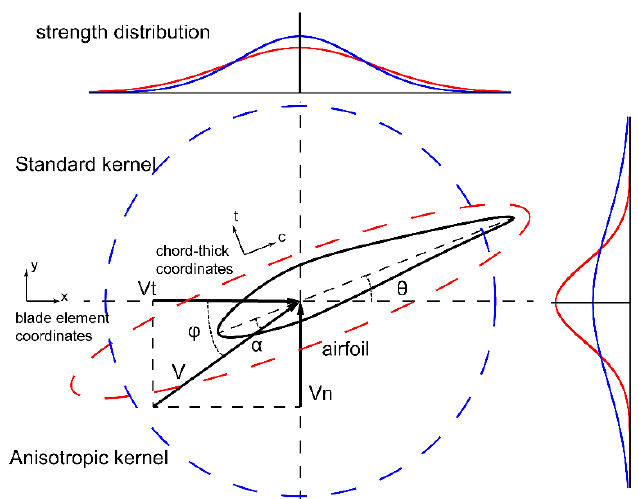
Figure 1. A schematic diagram of the influence range and strength distribution of two types of regularization kernel, the blue curve represents the standard kernel and the red one represents the anisotropic kernel.